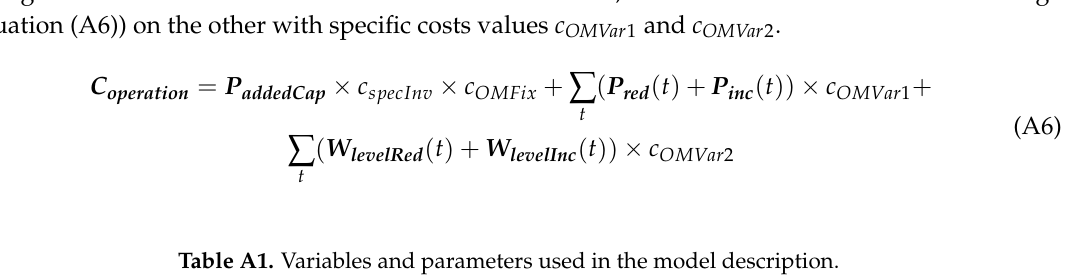
Table A1. Variables and parameters used in the model description.